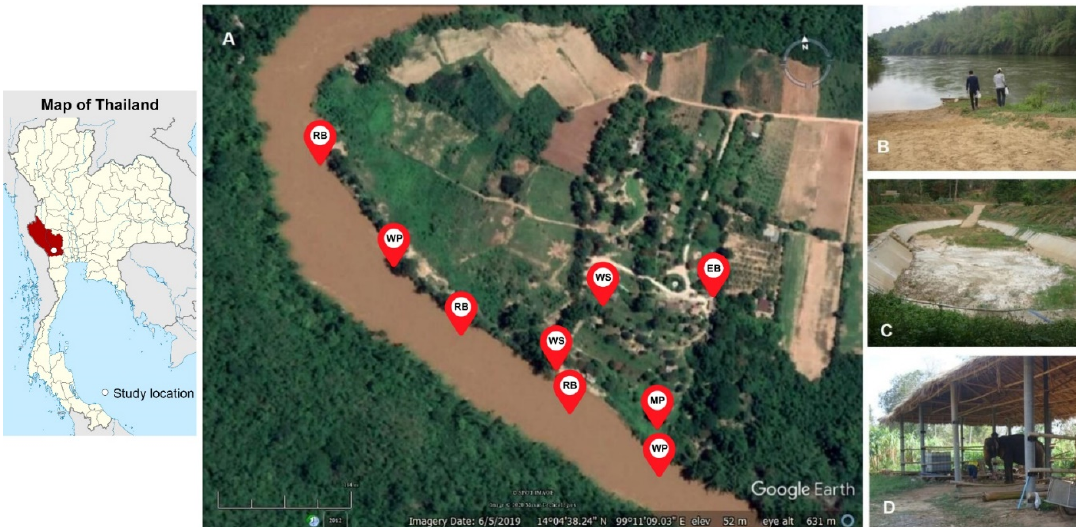
Figure 1. Map of the study location and the sampling locations of the environmental samples in the elephant camp areas ( A ). The sampling spots were marked on the map as follows: EB; Elephant barn, MP; Mud pond, RB; River beach, WP; Water pumping station and WS; Water supplies. The images of the sampling locations were shown on the right panel including a river beach ( B ), a mud pond ( C ), and an elephant barn ( D ).